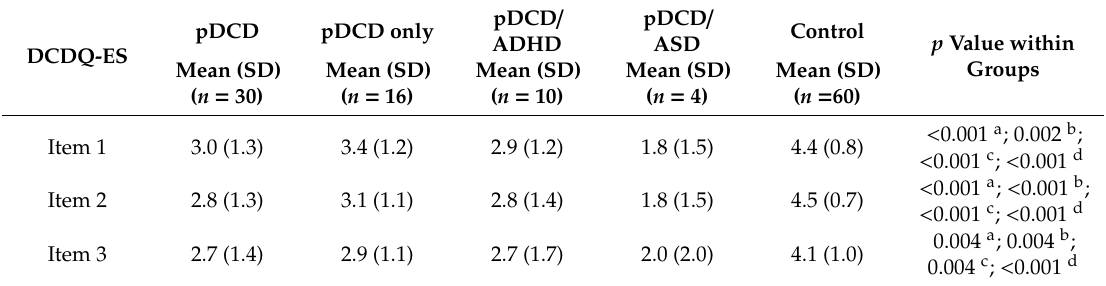
Table 2. DCDQ-ES total, subscale and item scores for pDCD and matched control group ( n = 90).